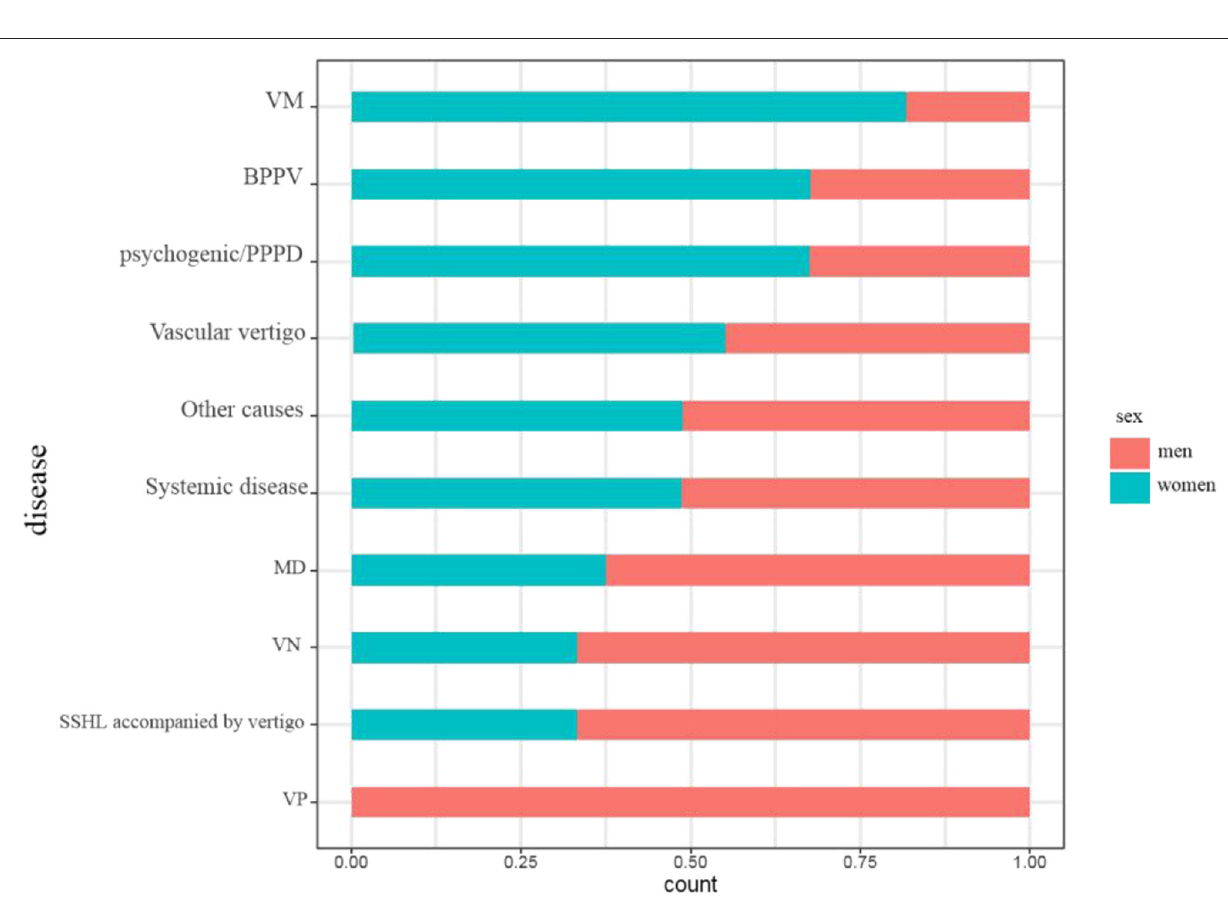
Frontiers in Neurology |